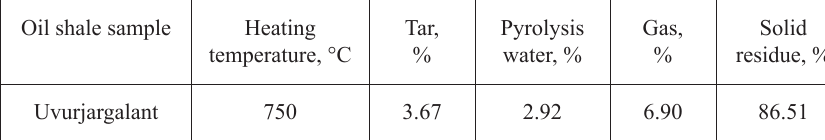
Tar, Pyrolysis Gas, Solid % water, % % residue, %